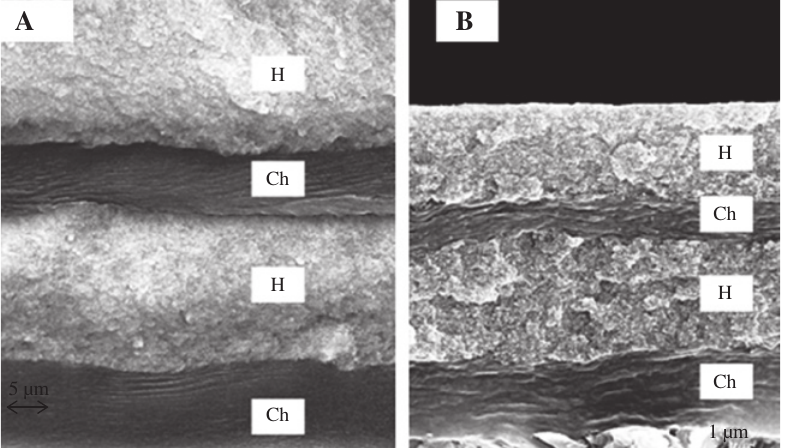
Figure 3: (A, B) Cross section of the prepared FGM having a layer of different materials in the form of laminates, where hydroxyapatite (H) and chitosan (Ch) form different layers